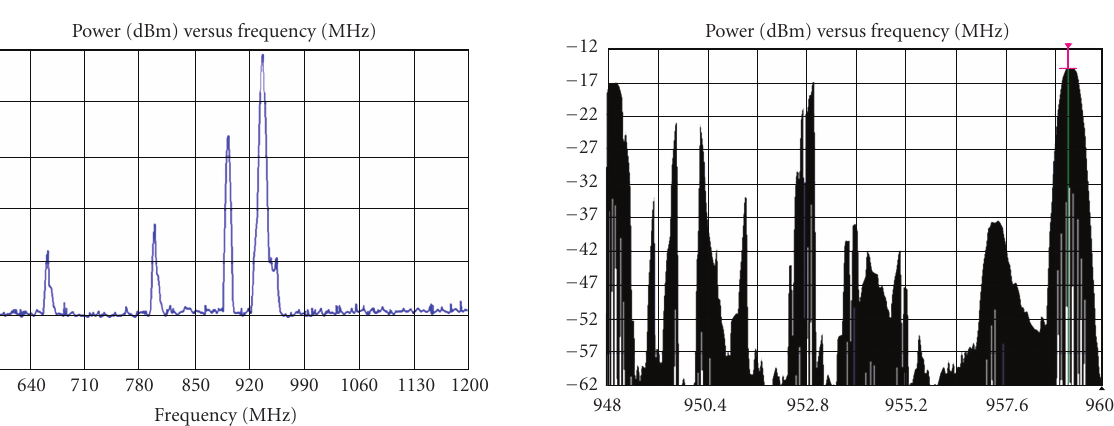
Figure 1: Snapshot of a low-density area Spectrum.